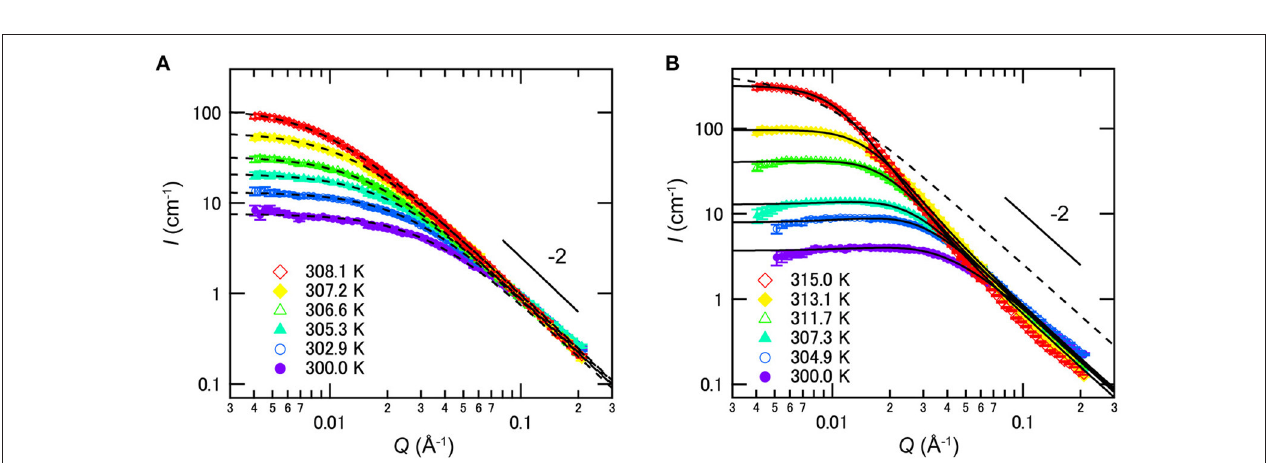
FIGURE 9 | Temperature dependences of SANS profiles of mixtures of D 2 O/3MP ( φ 3MP = 0.35) (A) without NaBPh 4 and (B) with 6 mmol/L of NaBPh 4 . The dashed and solid lines are fitting results according to the Ornstein-Zernike equation [ 47] and Equation (9), respectively. Error bars in the SANS profiles denote ± 1 standard deviation. The figure is reproduced from Sadakane et al. [22] (Copyright The Royal Society of Chemistry 2011). As per the copyright holder’s policies, no permission is required for the use of figures by the authors of the original article.